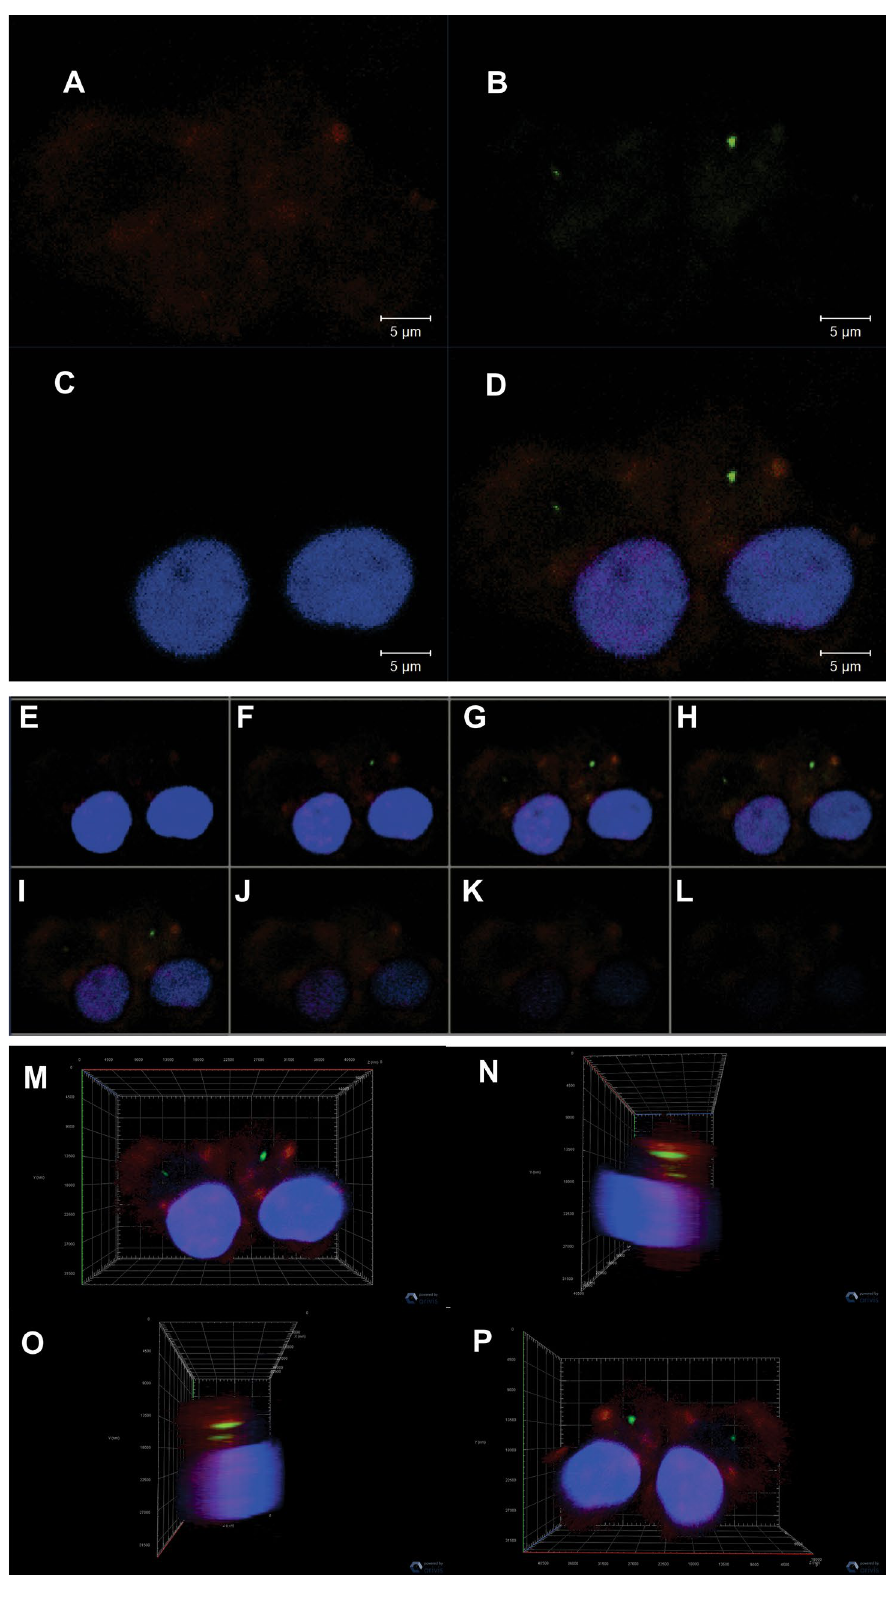
Figure 5. Illustration of EV internalization by mDCs using confocal microscopy. ( A ) cells labeled with CD209 (red), a dendritic cell transmembrane antigen; ( B ) EVs stained with PKH67 (green); ( C ) nuclear staining with DAPI (blue); ( D ) Merge of CD209, DAPI and PKH67; ( E – L ) Sequential images using the z-stack tool of confocal microscopy depicting EVs inside the dendritic cells. Three-dimensional images of EVs and mDCs displayed in four angles of 45 ° displaying nuclei (blue), CD209 (red), EVs (green); ( M ) front view of the cells; ( N ) left lateral view of the cells; ( O ) right lateral view of the cells; ( P ) back view of the cells, indicating that the EVs were internalized by